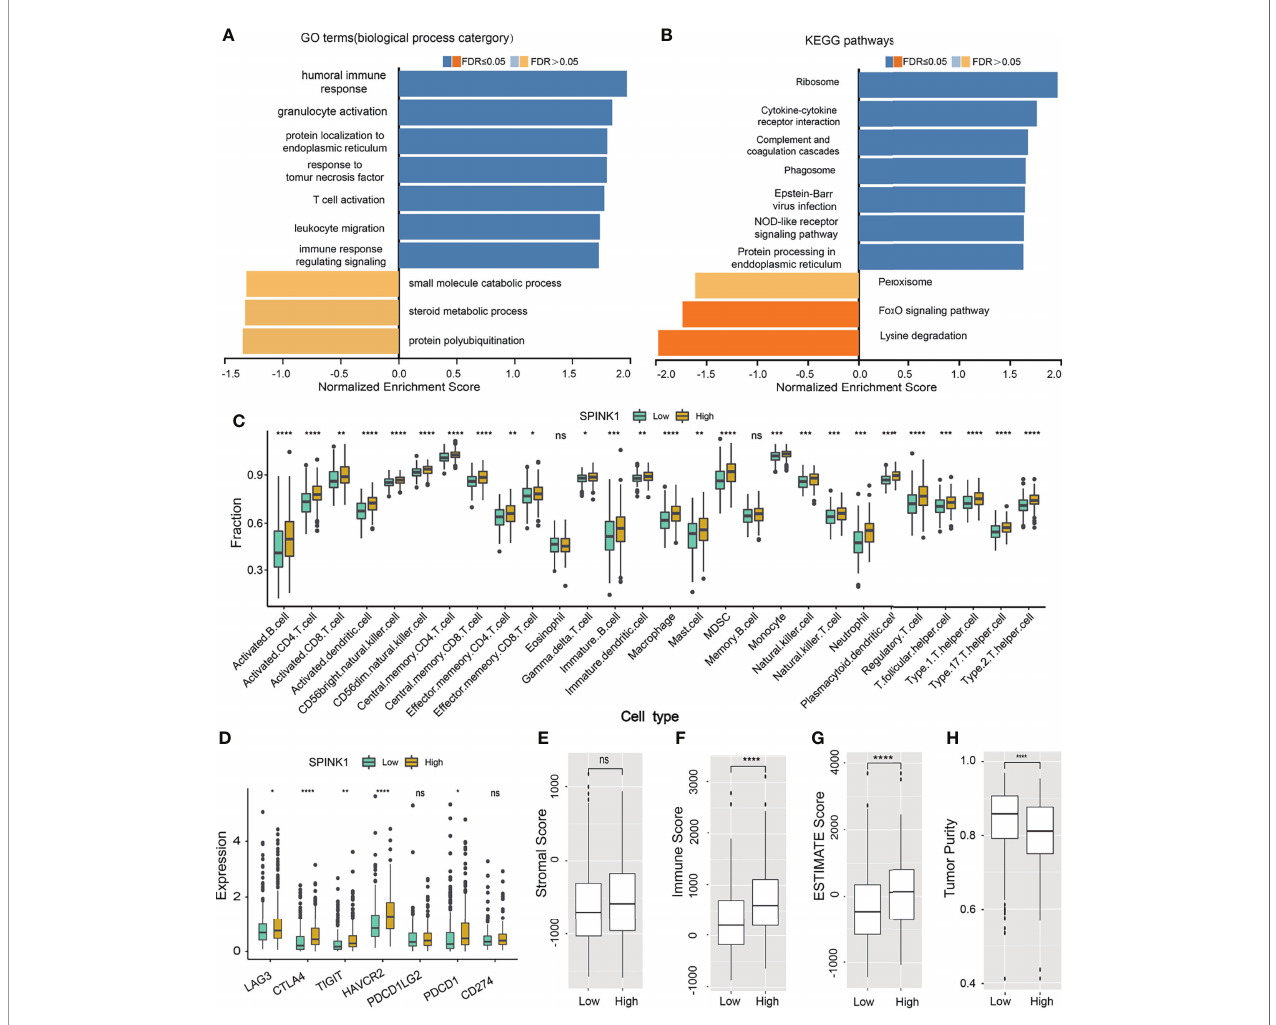
FIGURE 8 | SPINK1 -related gene set enrichment analyses (GSEA) and SPINK1 , tumor in fi ltrating microenvironment (TIME) (A, B) SPINK1 -associated gene set enrichment analyses (GSEA) of GO terms (biological process categories) and KEGG pathways using HCC RNAseq data from LinkedOmics database. (C) Relationships among SPINK1 expression abundance (low-blue vs high-yellow expression groups) and those of 28 subtypes of tumor in fi ltrating immune cells in terms of compositions and contents in tissue specimens of HCC patients from TCGA dataset. (D) Correlations among SPINK1 and other seven immune checkpoints molecu1es in SPINK1 - low and -high abundance groups of above-mentioned HCC samples. (E – H) Correlations among SPINK1 and scores of ‘ stromal ’ , ‘ immune ’ , ‘ estimate ’ and ‘ tumor purity ’ in SPINK1 - low and -high expression groups of same cohort of patient samples, respectively. NS, no signi fi cance; *, P < 0.05; **, P < 0.01; ***, P < 0.001; ****, P <